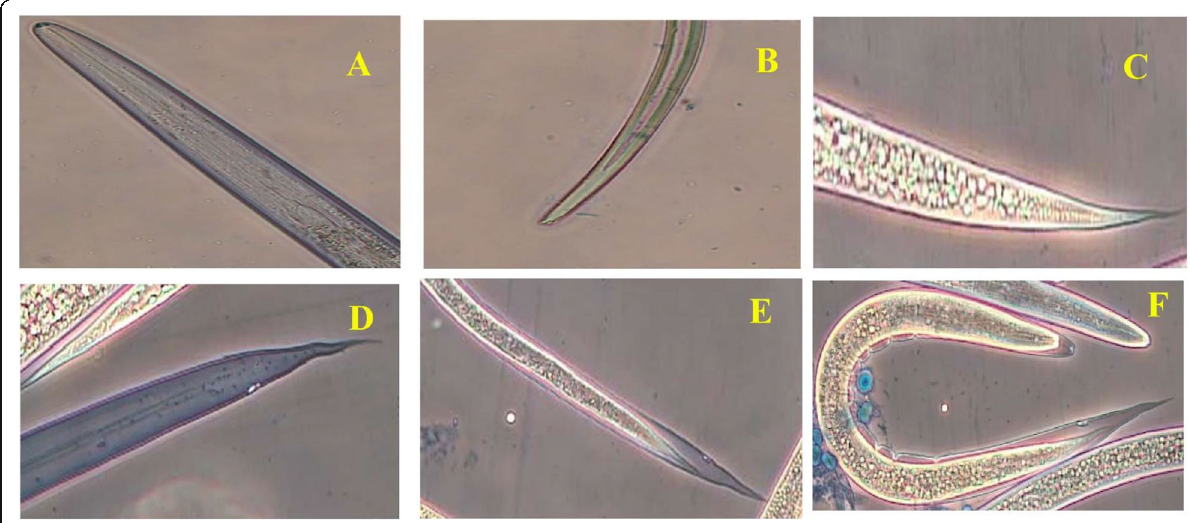
Fig. 2 a Head area exaggerating the mouth and distinct lips of an adult. b Male tail end. c Pointed female tail. d Tail with a dorsal constriction. e , f Tail with a hyaline layer in the